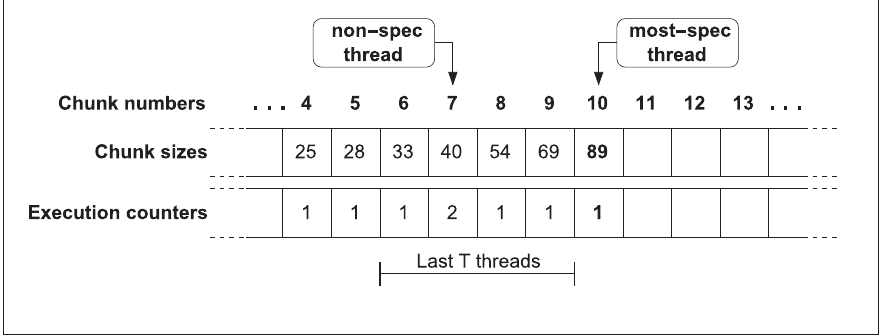
Fig 2. JIT scheduling, dynamic approach. The first time chunk 10 is executed, its size is calculated using the JIT scheduling function and its execution counter is set to 1. The size will be preserved regardless of the number of re- executions of chunk